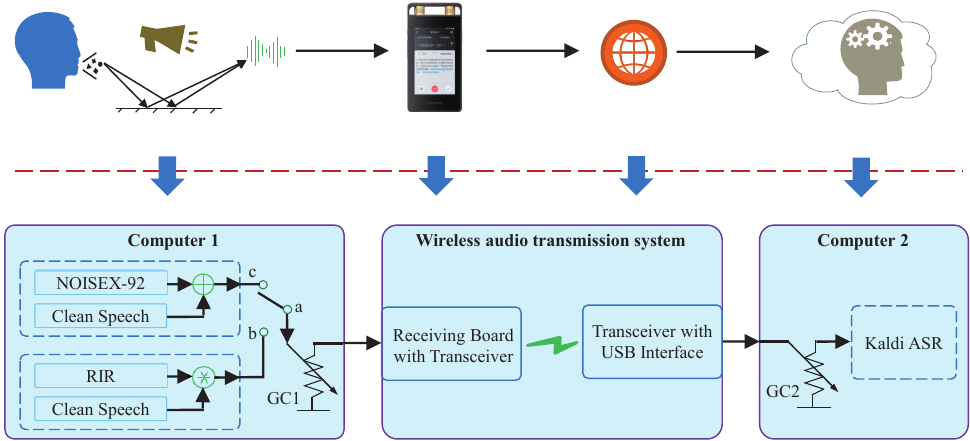
Figure 7. ASR experiment block diagram and the corresponding relationship between the experiment setup ( below the dotted line ) and the practical ASR system ( above the dotted line